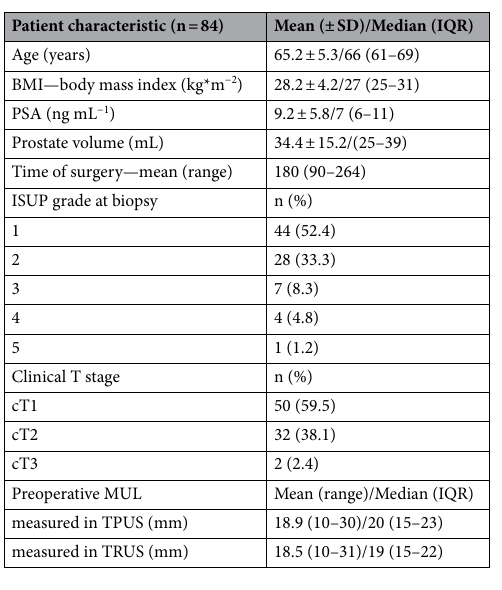
Table 2. Clinical and demographic characteristics of patients included in the study (n = 84). BMI body mass index, PSA prostate specific antygen, ISUP International Society of Urological Pathology,